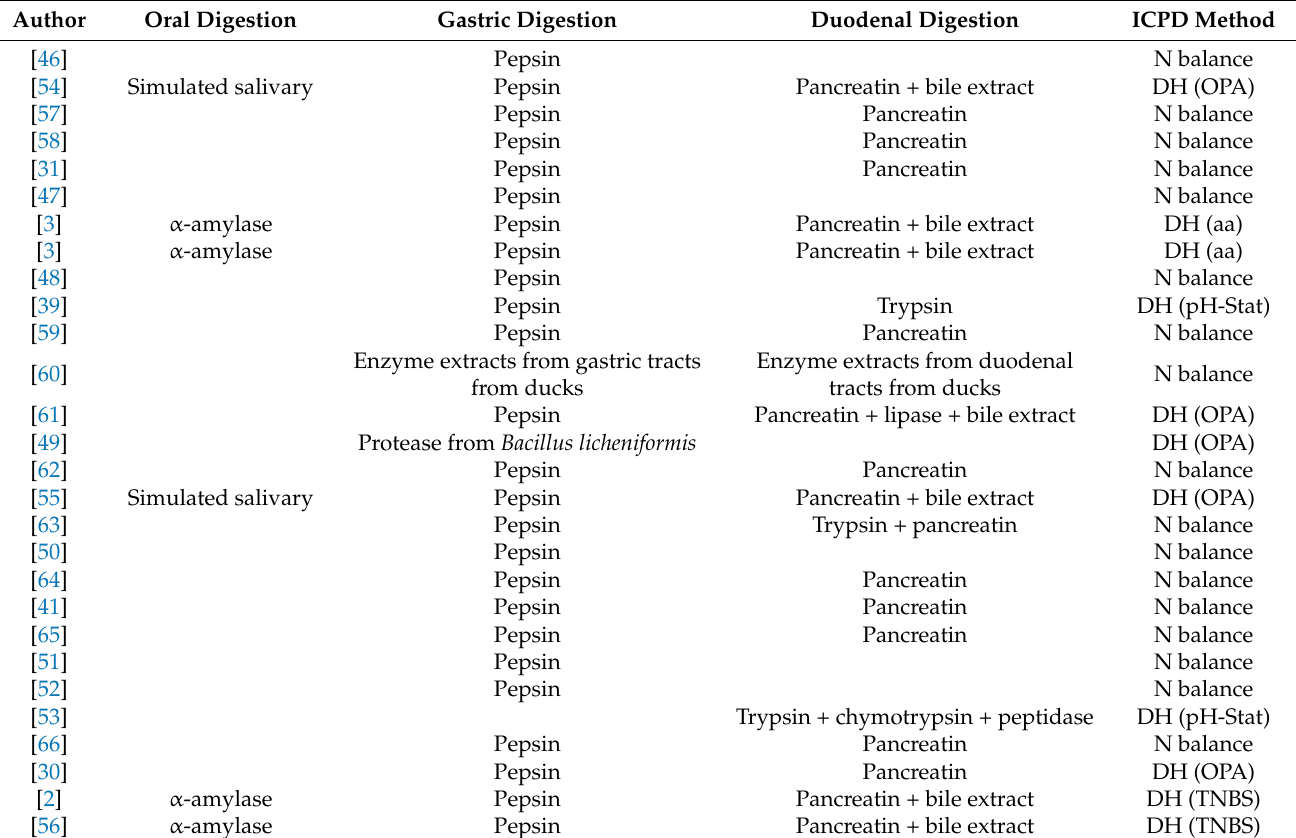
Table 2. Summary of methods and enzymes used in the study of insects’ meal